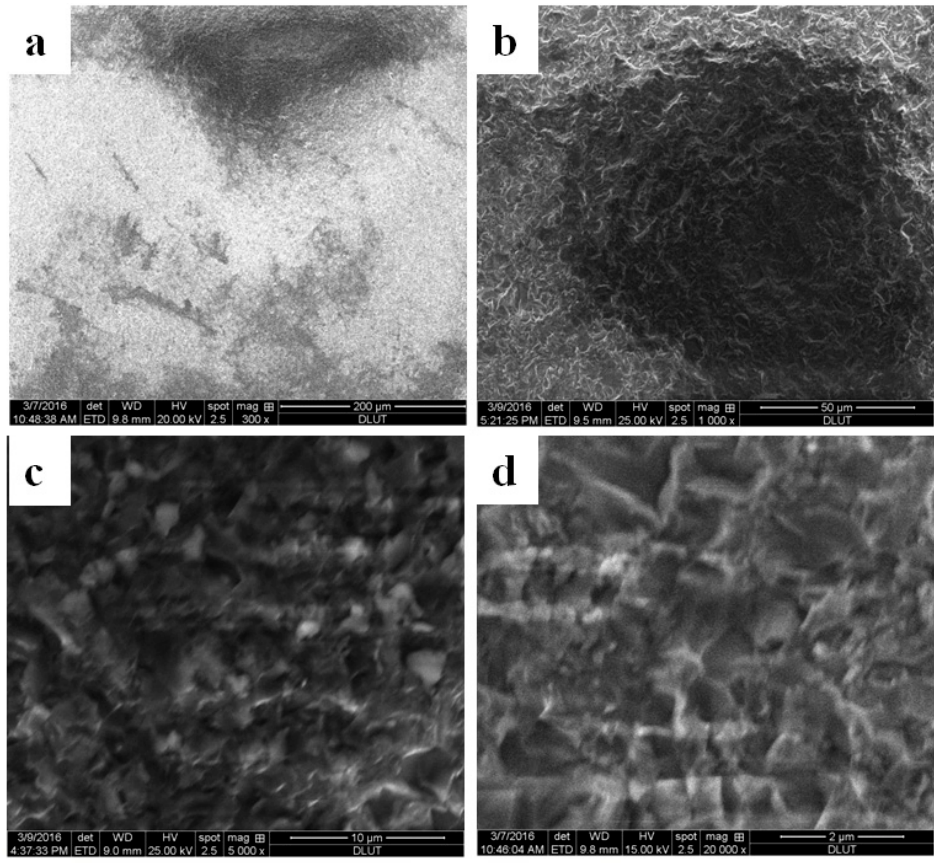
Figure 7. The SEM images of the quartz crystal sheet surfaces.